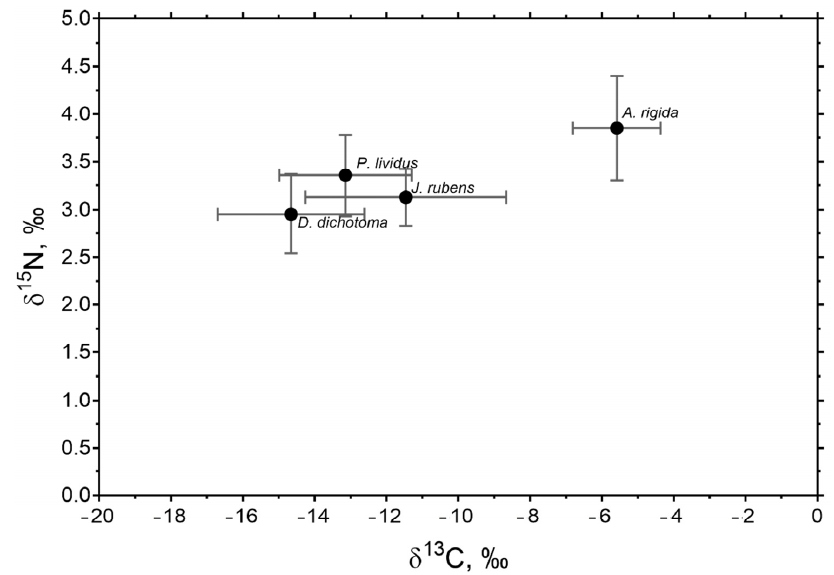
Figure 3. Average values of δ 13 C and δ 15 N for P. lividus and macroalgae collected at all sites and in both seasons in the study area. Values are X ± SE. Amphiroa rigida and Jania rubens are of the order Rhodophyta. Dictyota dichotoma is of the order Phaeophyta.